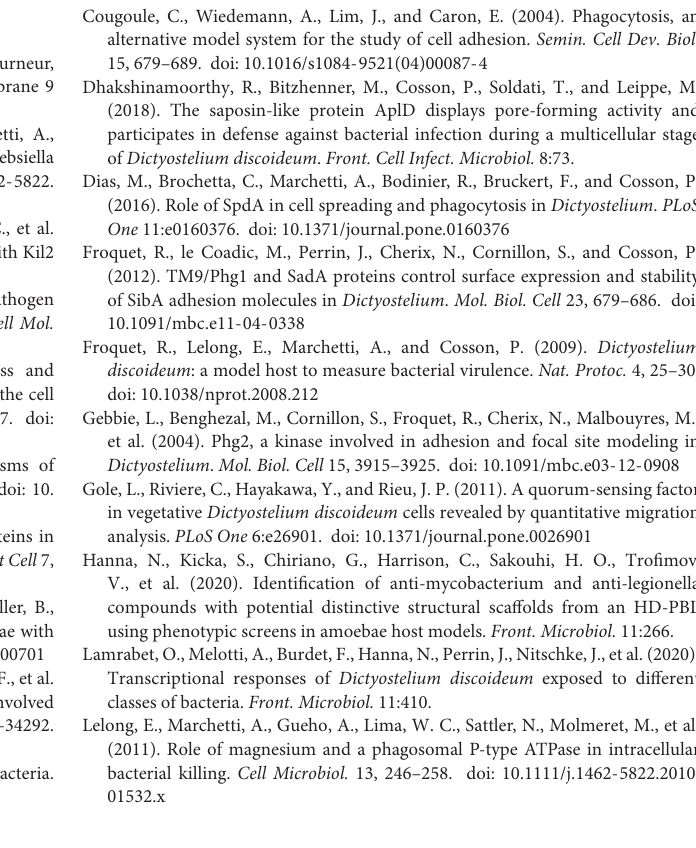
Figure 1 . Phagocytosis was expressed as the percentage of internalization by WT